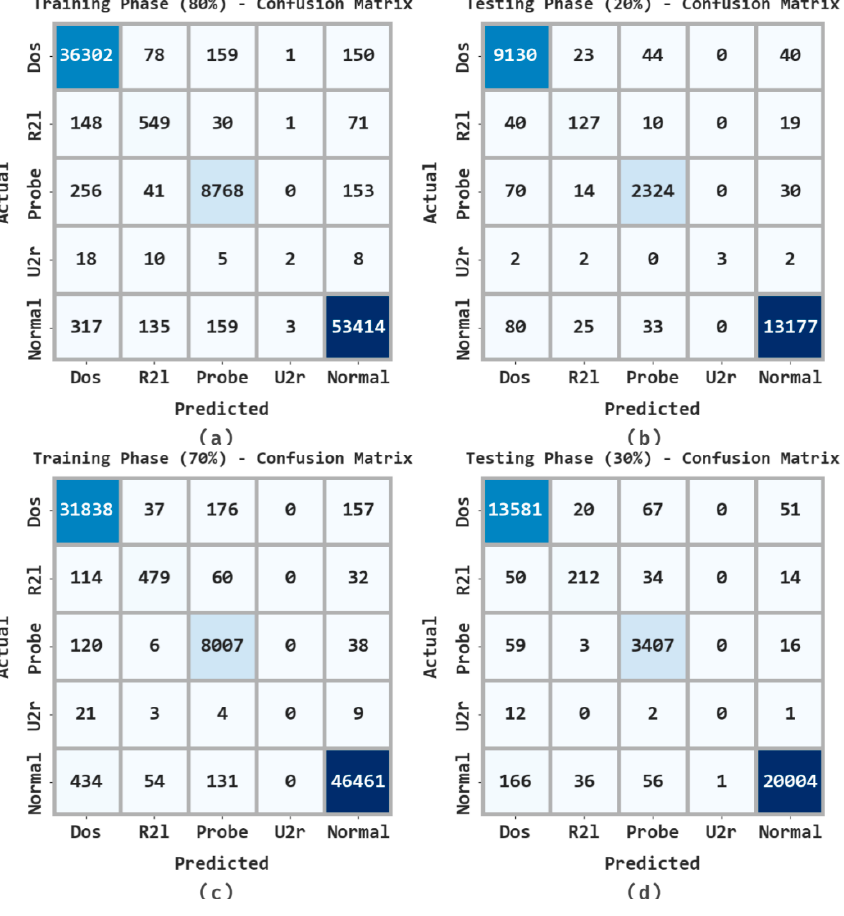
Figure 3. Confusion matrices of IMFL-IDSCS system ( a , b ) TR and TS databases of 80:20 and ( c , d ) TR and TS databases of 70:30.